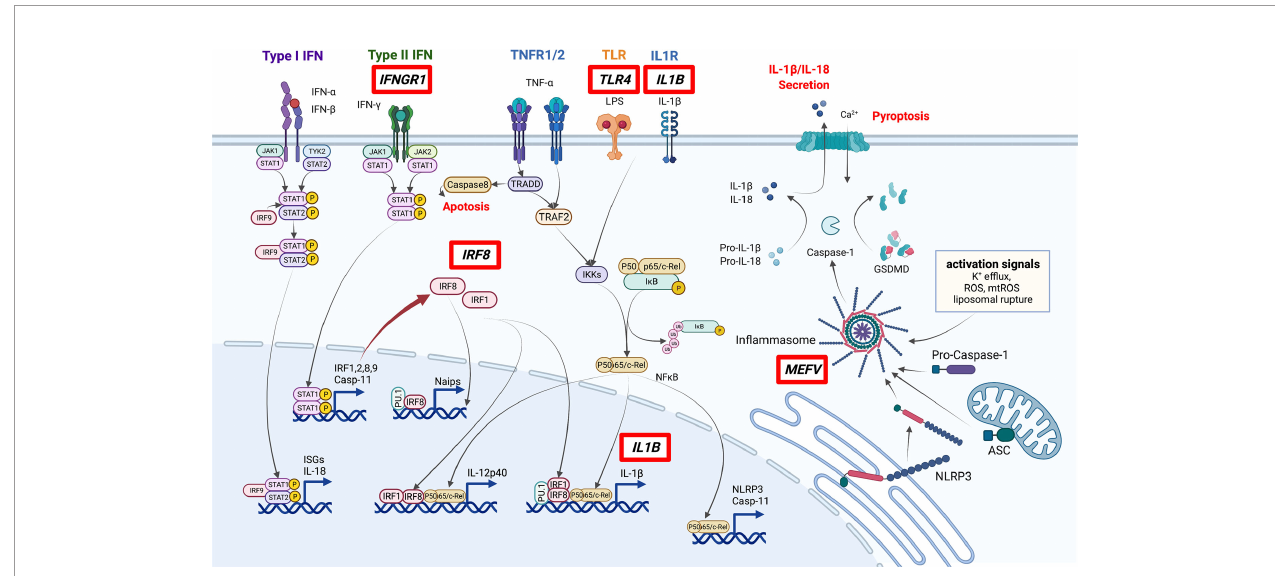
FIGURE 1 | Pathways involved in the pathogenesis of BD. Genes discovered by GWAS to be associated with BD (red boxes) include several involved in macrophage in fl ammation. In particular, IRF8 and MEFV are important in the regulation of STAT signaling and in fl ammasome activation. ISGs: Interferon-stimulated genes. This fi gure was created with BioRender.com.